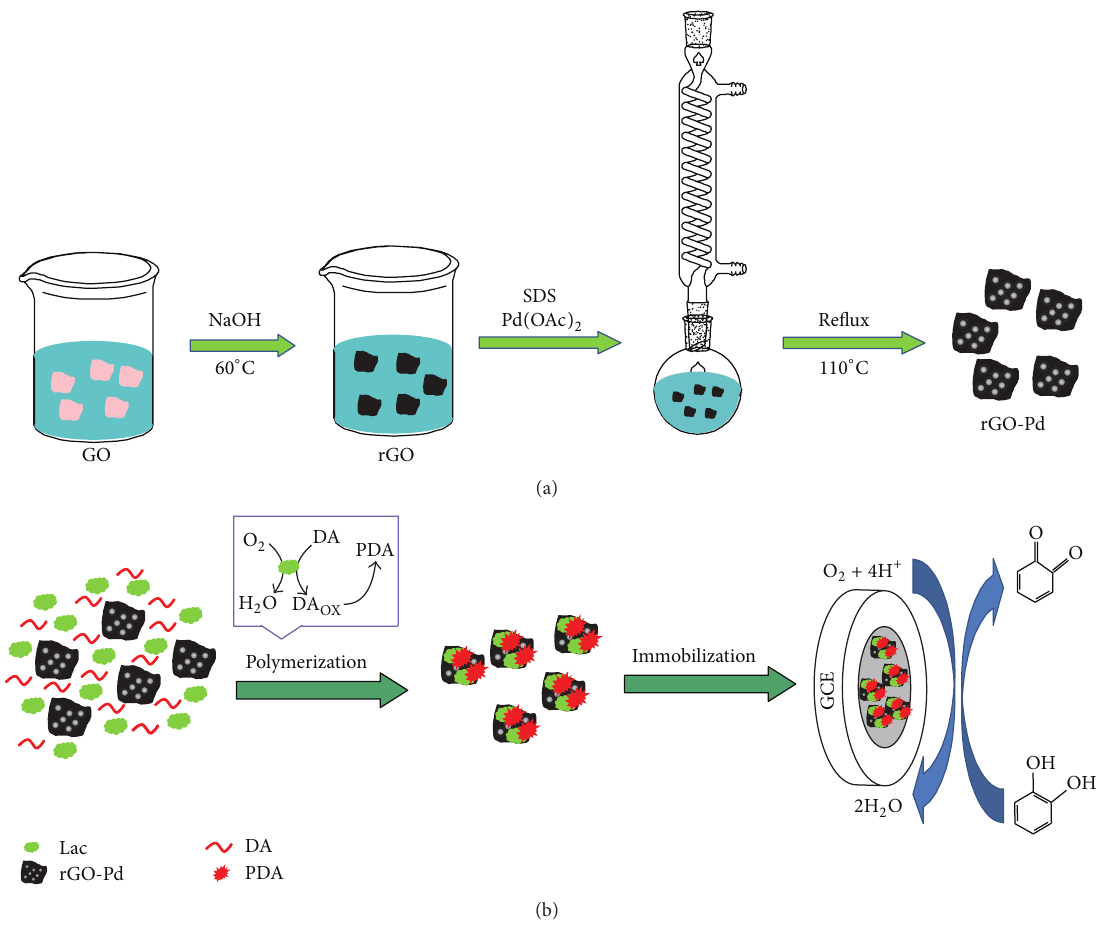
Figure 1: Schematic of the fabrication process of (a) rGO-Pd and (b) PDA-Lac-rGO-Pd composite and modified electrode.